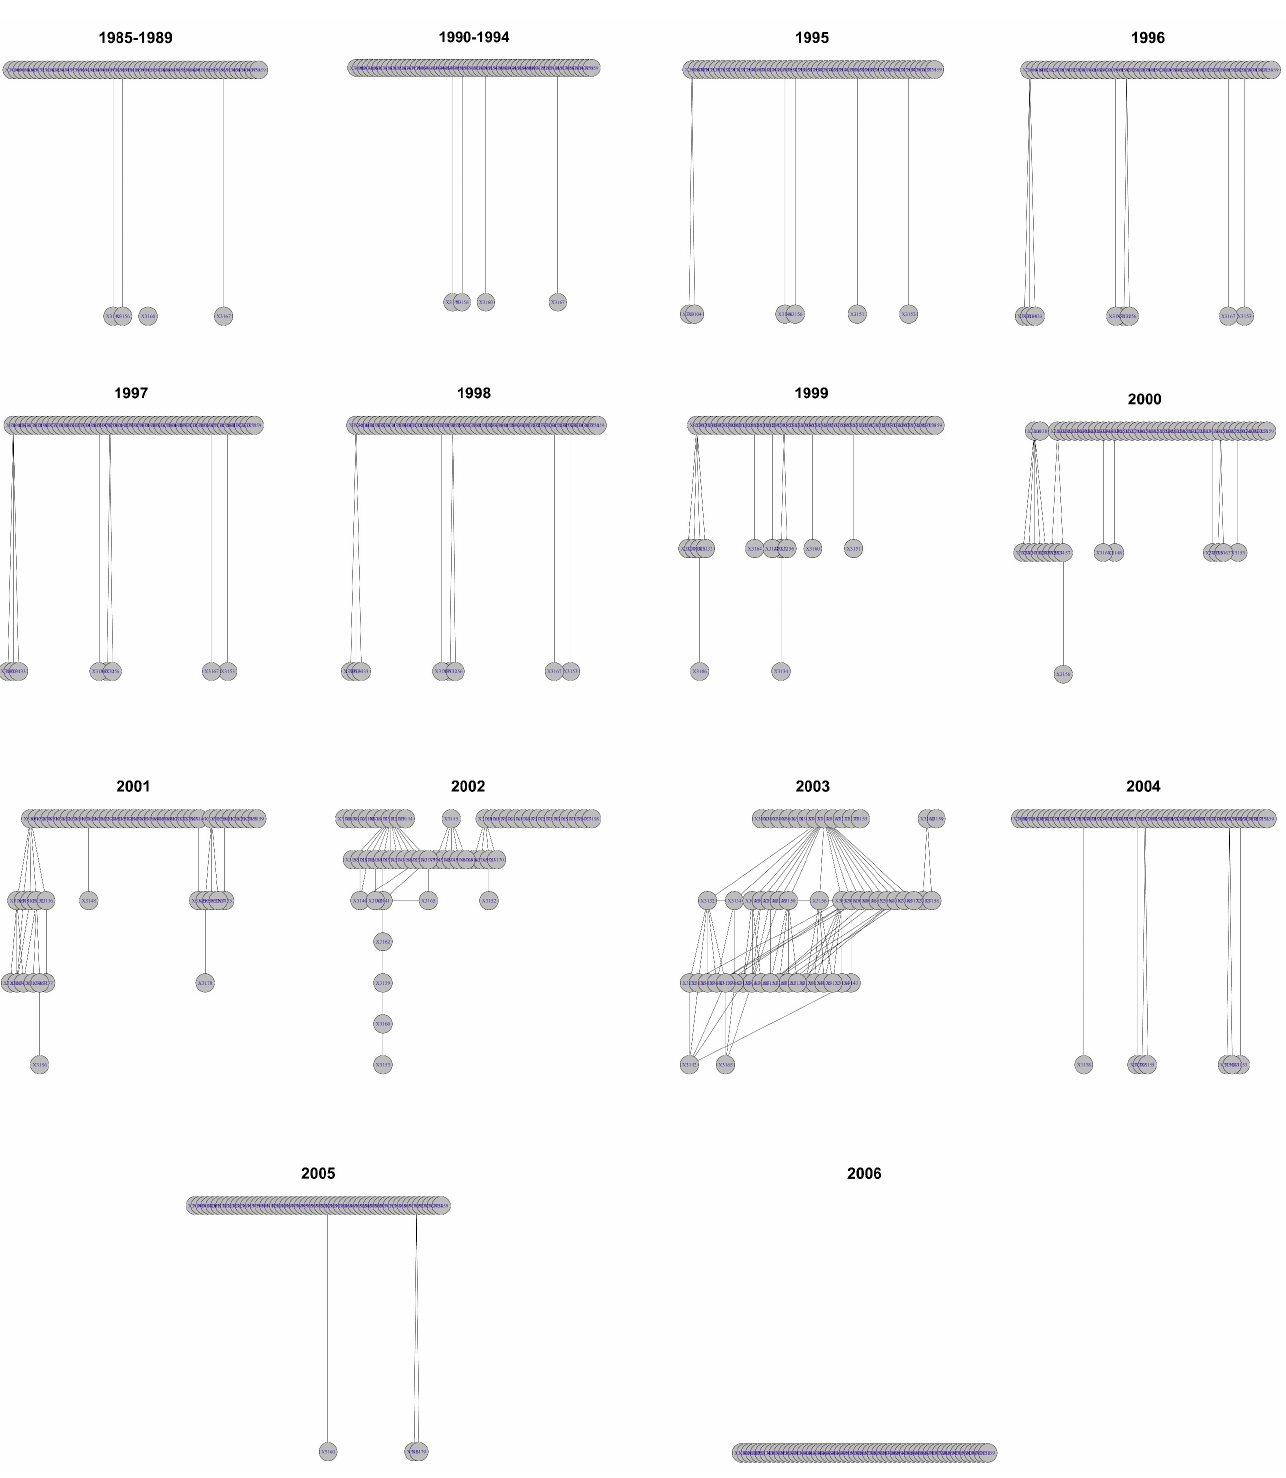
Figure 3. Temporal development of the hierarchical structure of “Al-Qaeda section of Madrid”. We observe a change of centralization in 2003.